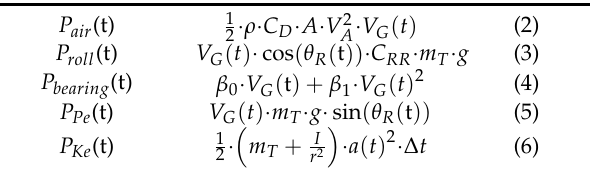
Table 1. Resistance power equations.